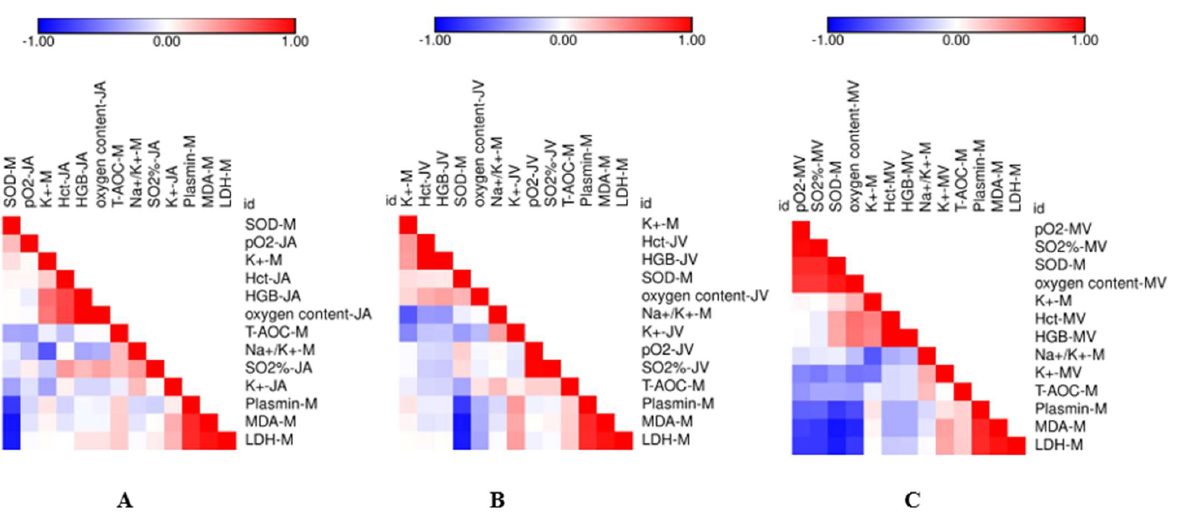
Figure 1. Pearson correlation between oxidative stress/permeability related index in the milk and blood gas profiles in coccygeal artery ( A ), coccygeal vein ( B ), and mammary vein ( C ).